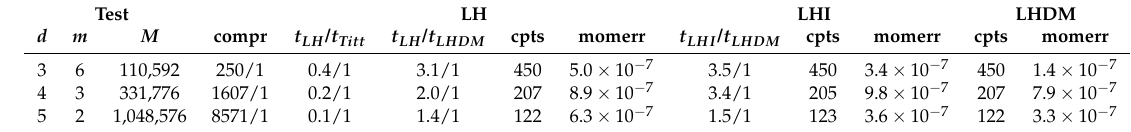
Table 4. Results of numerical tests on M = ( 2 km ) d Chebyshev’s nodes, with k = 4, with different dimensions and degrees: compr = M / mean ( cpts ) is the mean compression ratio obtained by the three methods listed; t LH / t Titt is the ratio between the execution time of LH and that of Titterington algorithm; t LH / t LHDM ( t LHI / t LHDM ) is the ratio between the execution time of LH (LHI) and that of LHDM; cpts is the number of compressed Tchakaloff points and momerr is the final moment